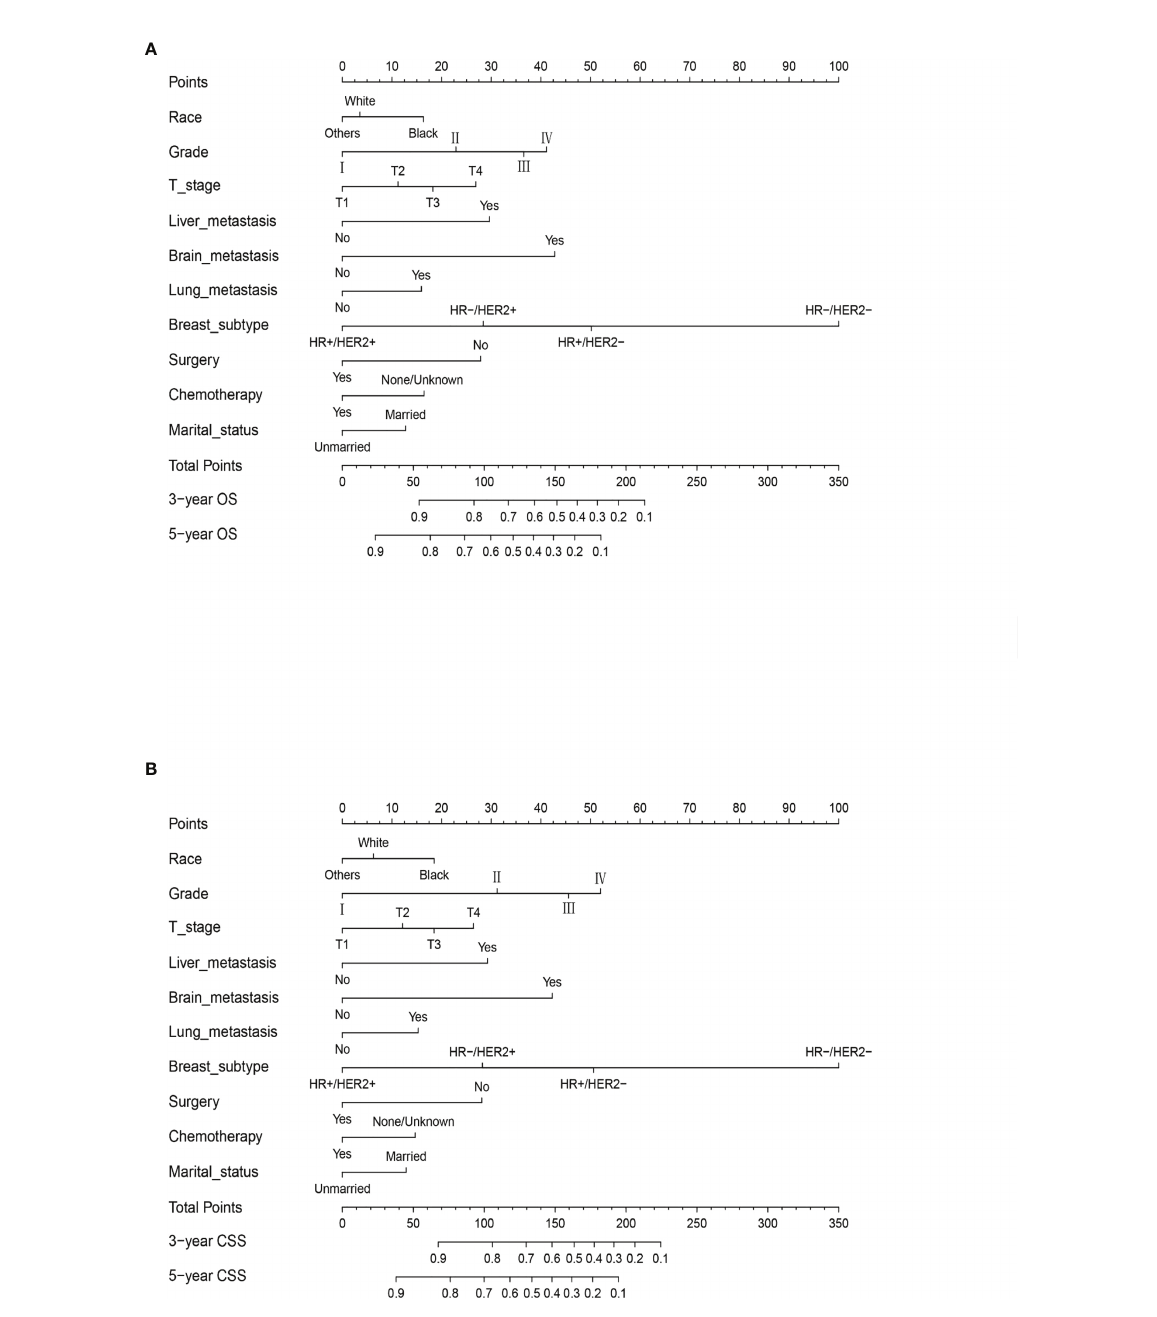
FIGURE 3 The prognostic nomograms for OS (A) and CSS (B) in MBC patients of childbearing age in the training cohort. Example of the nomogram. The nomogram can be used to calculate the prediction probability of OS and CSS. The nomogram shows the in fl uence of different prediction variables. The in fl uence of each variable is represented by the horizontal lines, with longer lines indicating a greater impact. The in fl uence of each variable is visualized through multiple points on the corresponding horizontal line. By adding points related to each variable, the expected score size can be read on the response horizontal line at the bottom of the